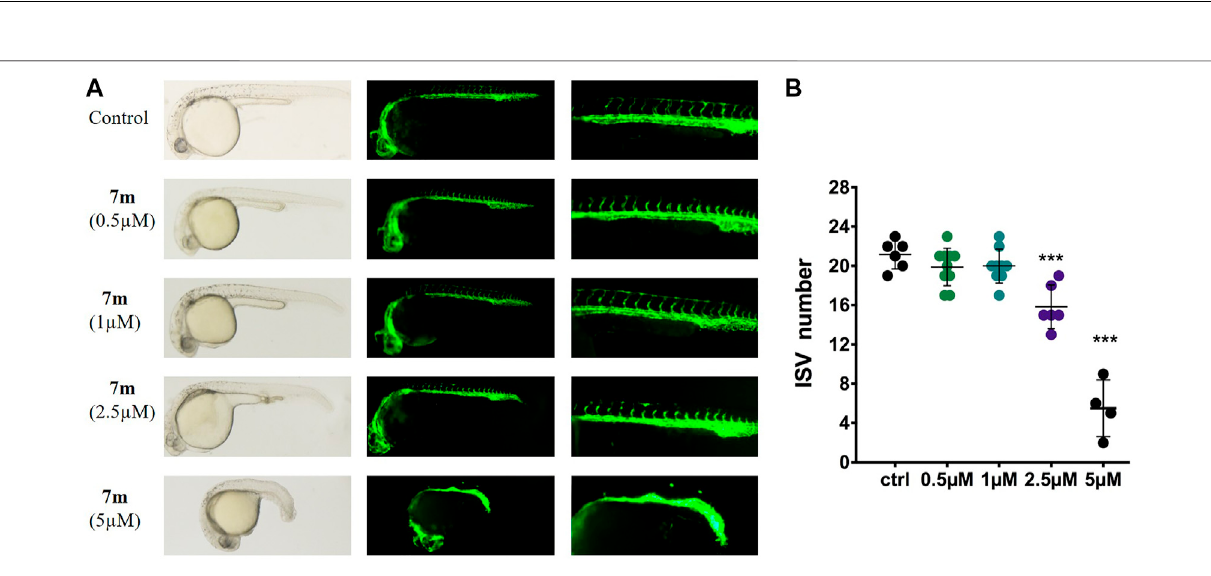
Frontiers in Chemistry |